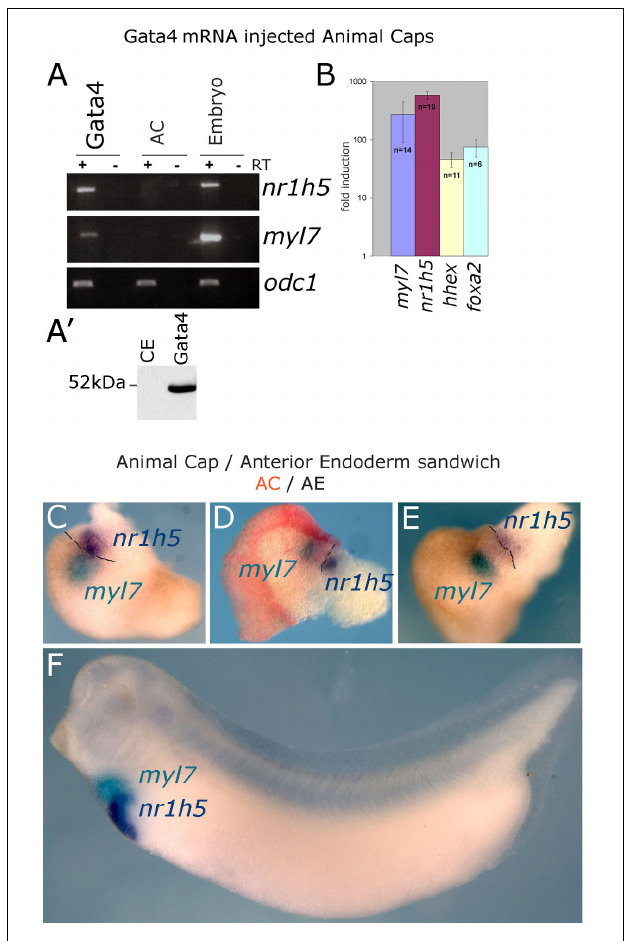
FIGURE 1 | Induction of hepatogenesis in Gata4-expressing AC explants and AC/AE conjugates. (A,B) Marker gene analysis in Gata4-expressing animal caps. (A) RT-PCR showing expression of cardiac fate marker myl7 , liver fate marker nr1h5 and control marker odc1 in Gata4 mRNA-injected ACs, control ACs and stage 33 sibling control embryo. Representative of four independent experiments. (A (cid:48) ) Western blotting shows efficient translation of exogenous Gata4 protein. An equivalent of 1 / 2 embryo at st. 9 from a sample of five embryos has been loaded on the gel. (B) qPCR showing fold difference in expression between Gata4 treated animal caps and control animal caps grown to st. 33, induction of expression of myl7 , nr1h5 , hhex and marker of endoderm foxa2 is shown. Number of independent experiments ( n ) and standard error of the mean are shown. (C–E) Cardiac and liver domains are adjacent in AC/AE conjugates and (F) age matched sibling controls. AC/AE conjugates (sandwiches) were cultured until sibling control embryos reached st. 34 and were processed for myl7 expression (turquoise) and nr1h5 (purple) by WMISH. AC-derived tissue is shown in pink/red. Three AC/AE examples are shown demonstrating adjacent expression domains of myl7 in the AC-derived tissue and nr1h5 in the AE-derived component of the explant (12/12 specimens showed the same pattern). Dashed line highlights the border between AC and